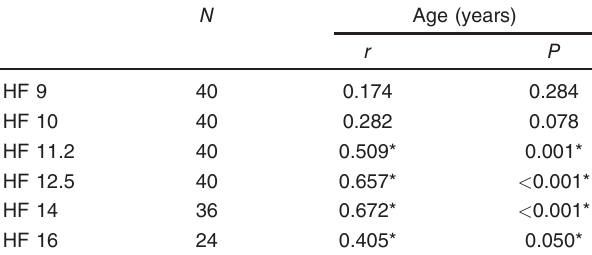
Table 7 Comparison between the two studied groups according to nonresponding cases Nonresponding cases